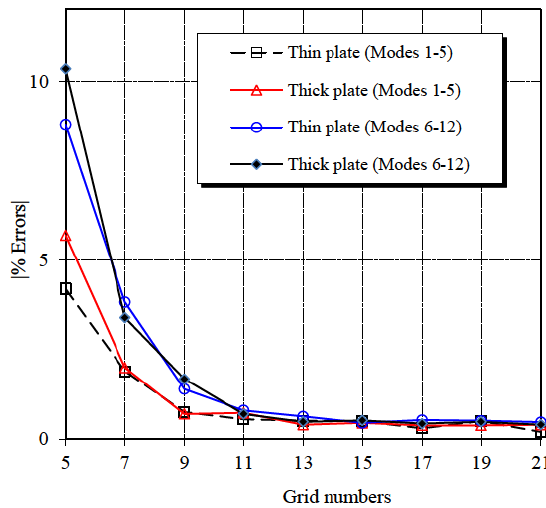
sults have good convergence with 11 grids in radial direc- tions for small modes with those in literatures. It is also concluded that, only 7 grid points in the